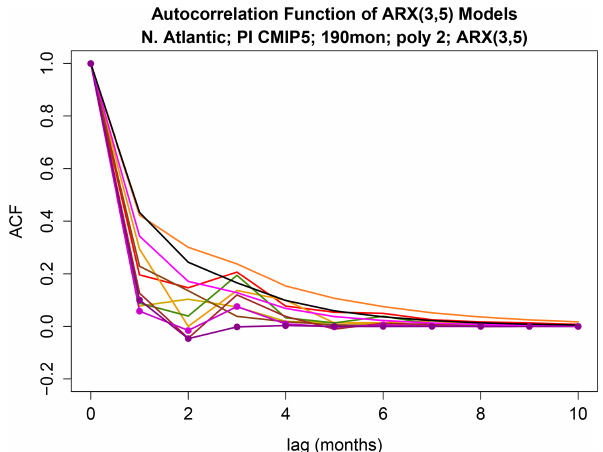
Figure 11. The autocorrelation function from each ARX(3,5) model. Dots indicate ACFs that differ significantly from that of ob- servations at the 5% level for FWER. The same color scheme as used in previous figures is used, including black for